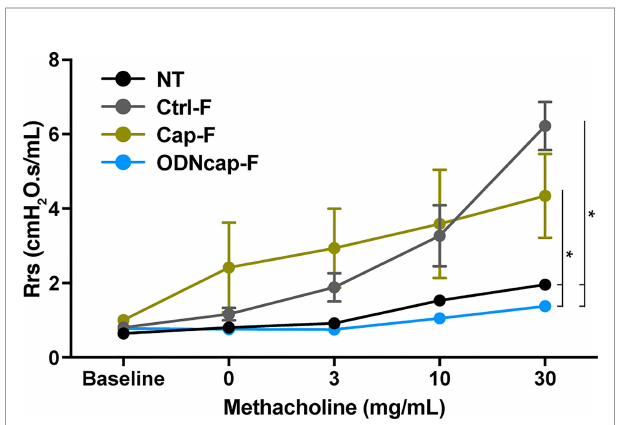
FIGURE 4 | ODNcap-Fattenuates airwayresponsiveness tomethacholine. On Day70, anesthetizedmice wereconnectedtoaventilator andthensequentially exposedtovariousinhaledconcentrationsofmethacholine(0to30mg/mL). Measurementsofrespiratorysystem resistance(Rrs) weremonitored( n =6).Data